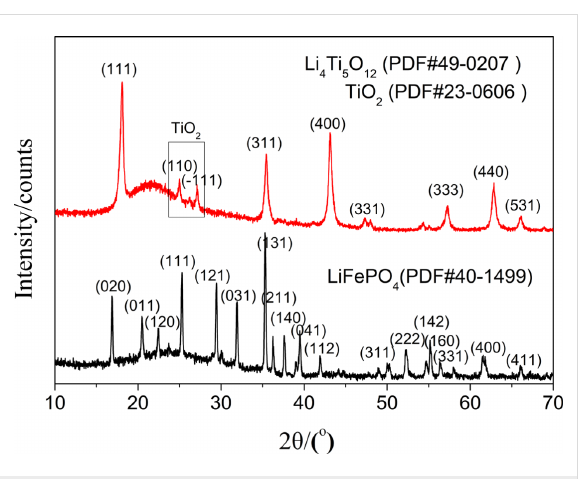
Figure 6: Raman spectra of LiFePO 4 and Li 4 Ti 5 O 12 fiber membranes.